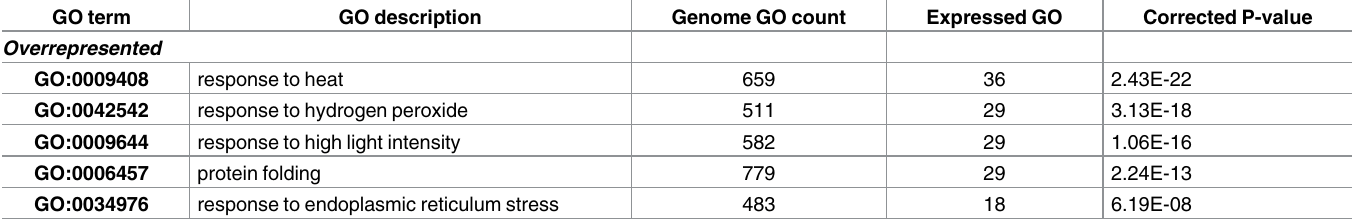
Table 2. GO enrichment analysis of the 139 differentially expressedtranscripts that are significantly higher at stage 9 compared to 7.2 after drying and common between 7.2D/7.2F and 9/7.2D. GO term